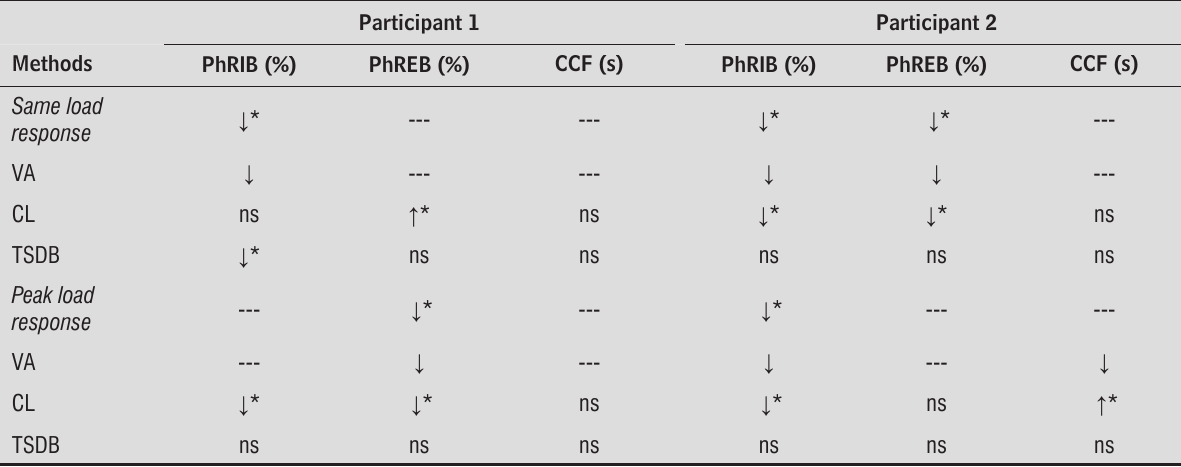
Table 3 - Response to intervention according to Visual Analysis, Celeration Line and Two Standard Deviation Band during same load and peak